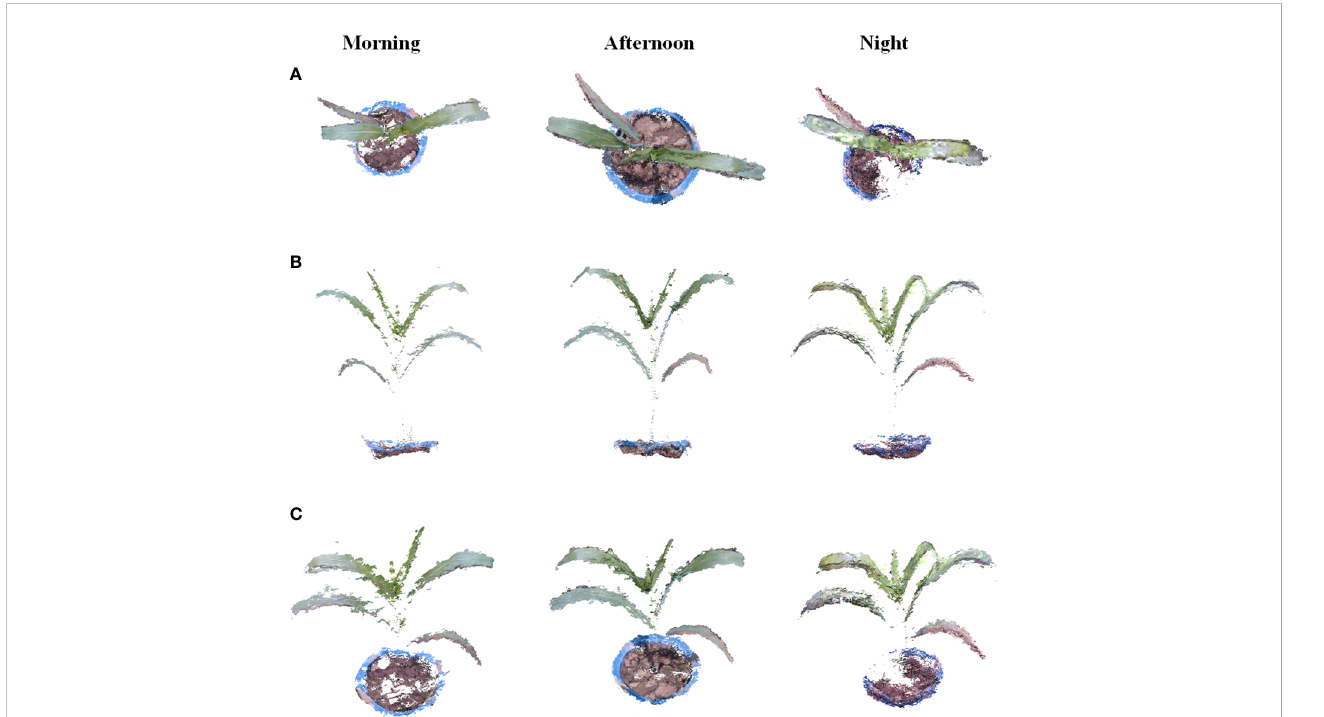
FIGURE 8 Results of the dynamic reconstruction of crops throughout the day of the experiment. (A, B) are different views of individual corn seedlings in the reconstructed point cloud. (B) shows different views of individual tobacco seedlings in the reconstructed point